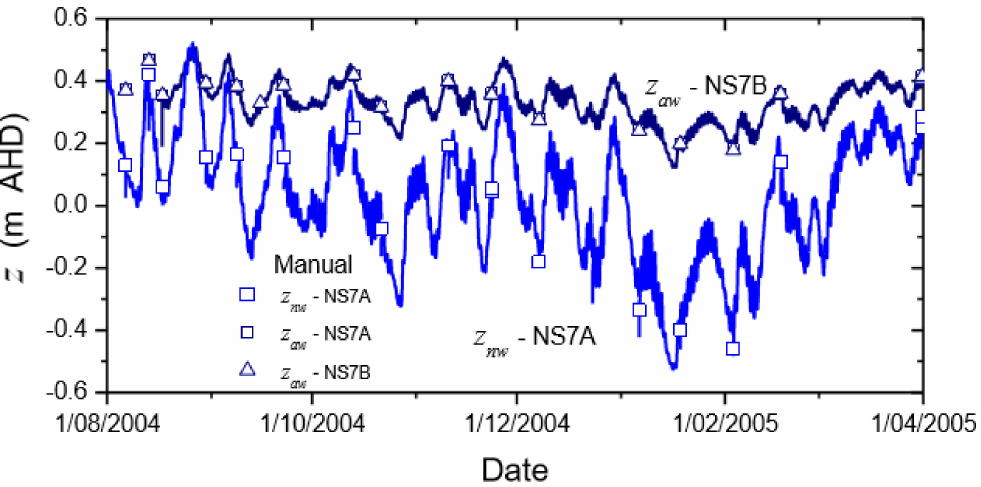
Figure 3. Measured elevations of the air / water interface and LNAPL / water interface